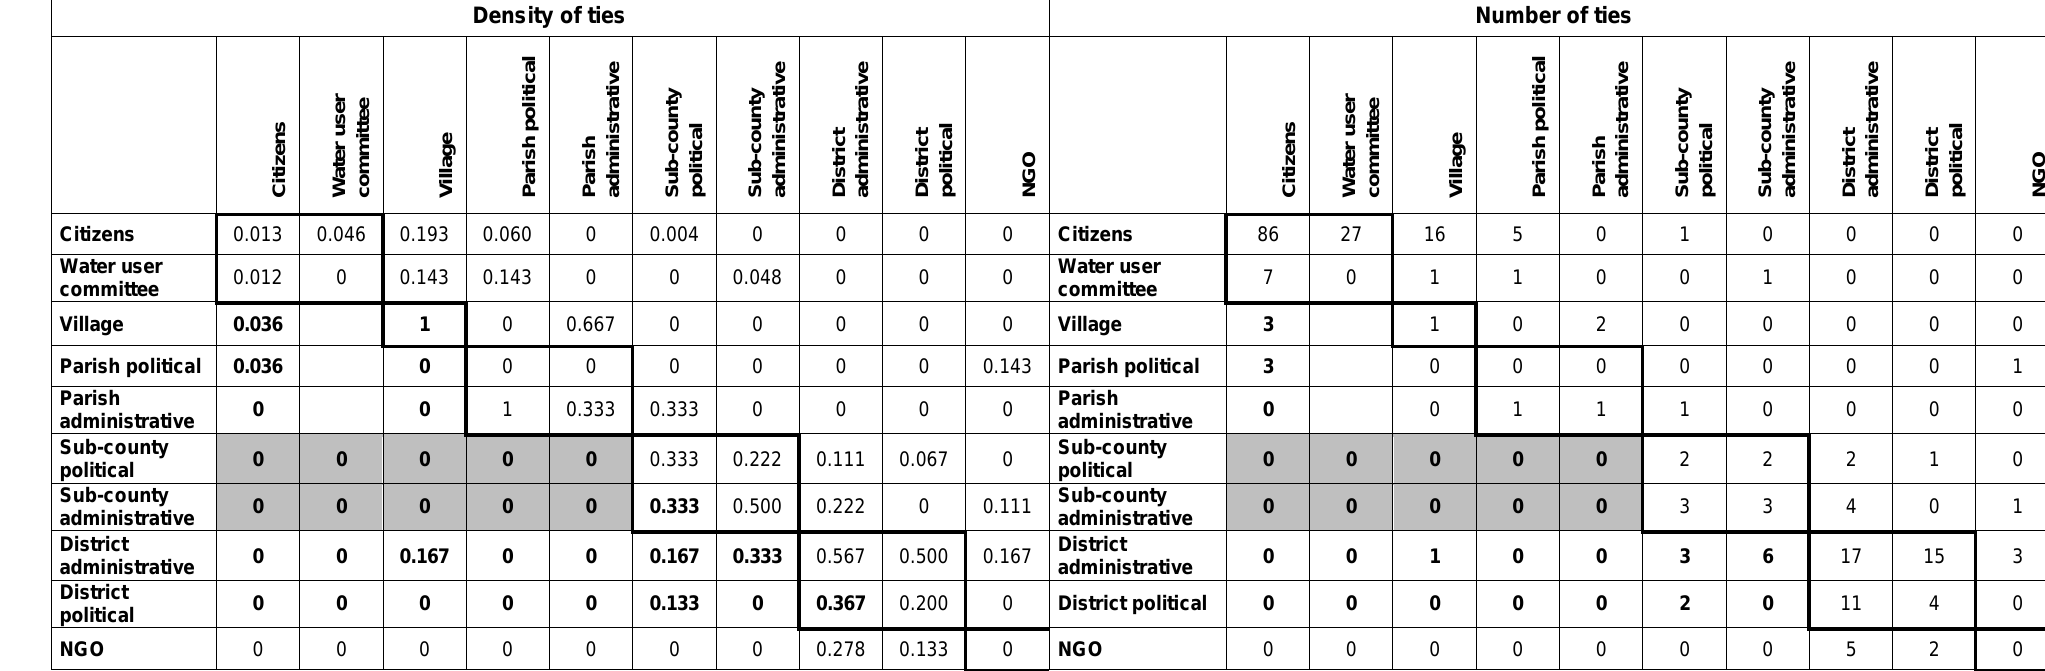
Table 5: Intensity of information exchange between all different actors of the information-sharing network on water-related information Density of ties Number of